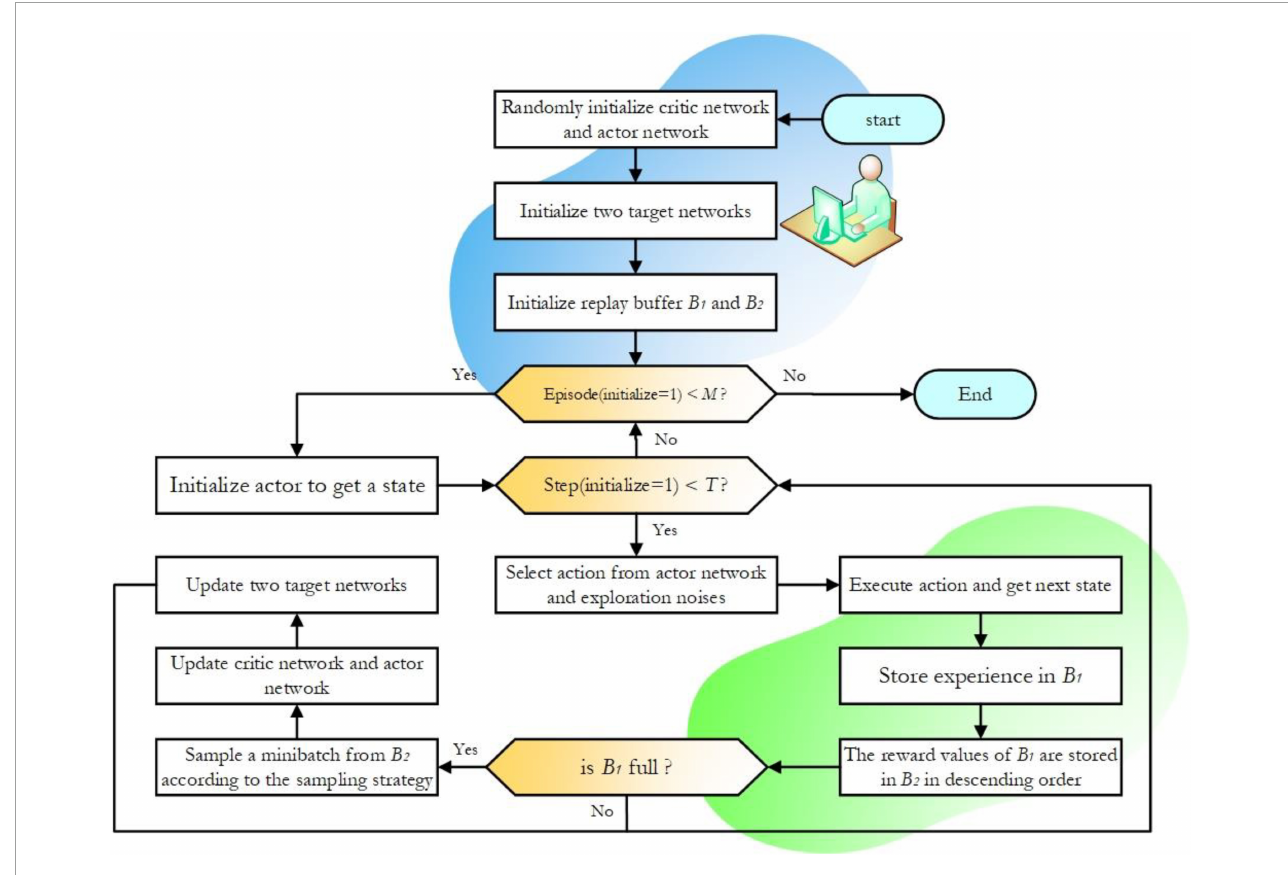
FIGURE5 Flowchart of the improved deep deterministic policy gradient (DDPG) algorithm.